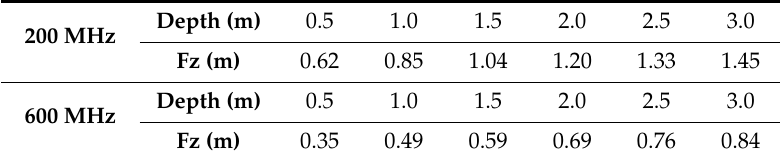
Table 1. Fresnel zone diameter at several depths (mean velocity 0.07 m /